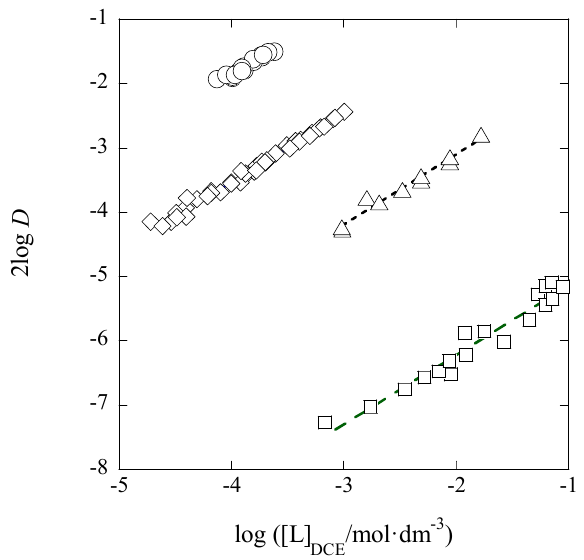
Figure 2. Plots of 2log D vs. log[L] DCE for the AgPic (circle: without excess HNO 3 ; diamond: 0.05 mol·dm − 3 HNO 3 in the w phase), AgClO 4 (triangle), and AgNO 3 (square) extraction with B18C6 (= L) into DCE.